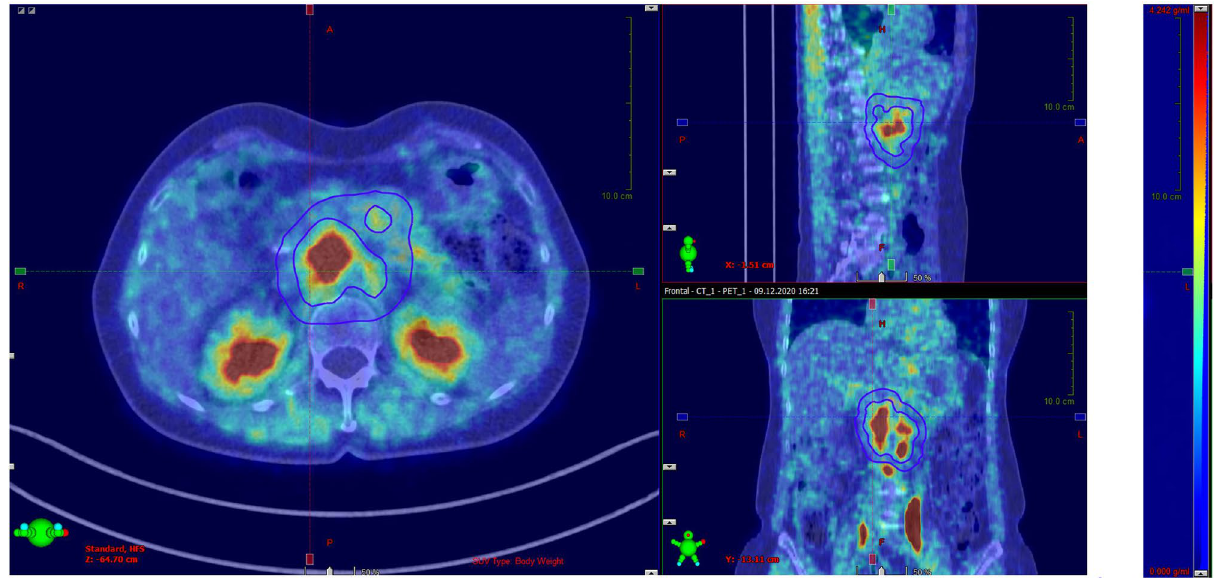
Figure 2. Showing patient H with a lymphonodular metastatic pancreatic ductal adenocarcinoma at timepoint t 1 . Fused mode [ 68 Ga]FAPI-PET/CT displaying assessment of physiological tracer activity distribution and the surrounding perilesional background uptake examined, left-side: axial reconstruction at the level of the kidneys, upper right-side: midline sagittal reconstruction, lower right-side coronal reconstruction [point-spread function (PSF) reconstruction; PET Rainbow 2D with colour blending yellow-blue, 27 min after 106 MBq [ 68 Ga]FAPI- injection]; likewise background uptake was determined (blue structure) for all index lesions in terms of SUV mean in a hollow sphere in 0.5–1.5 cm perilesional